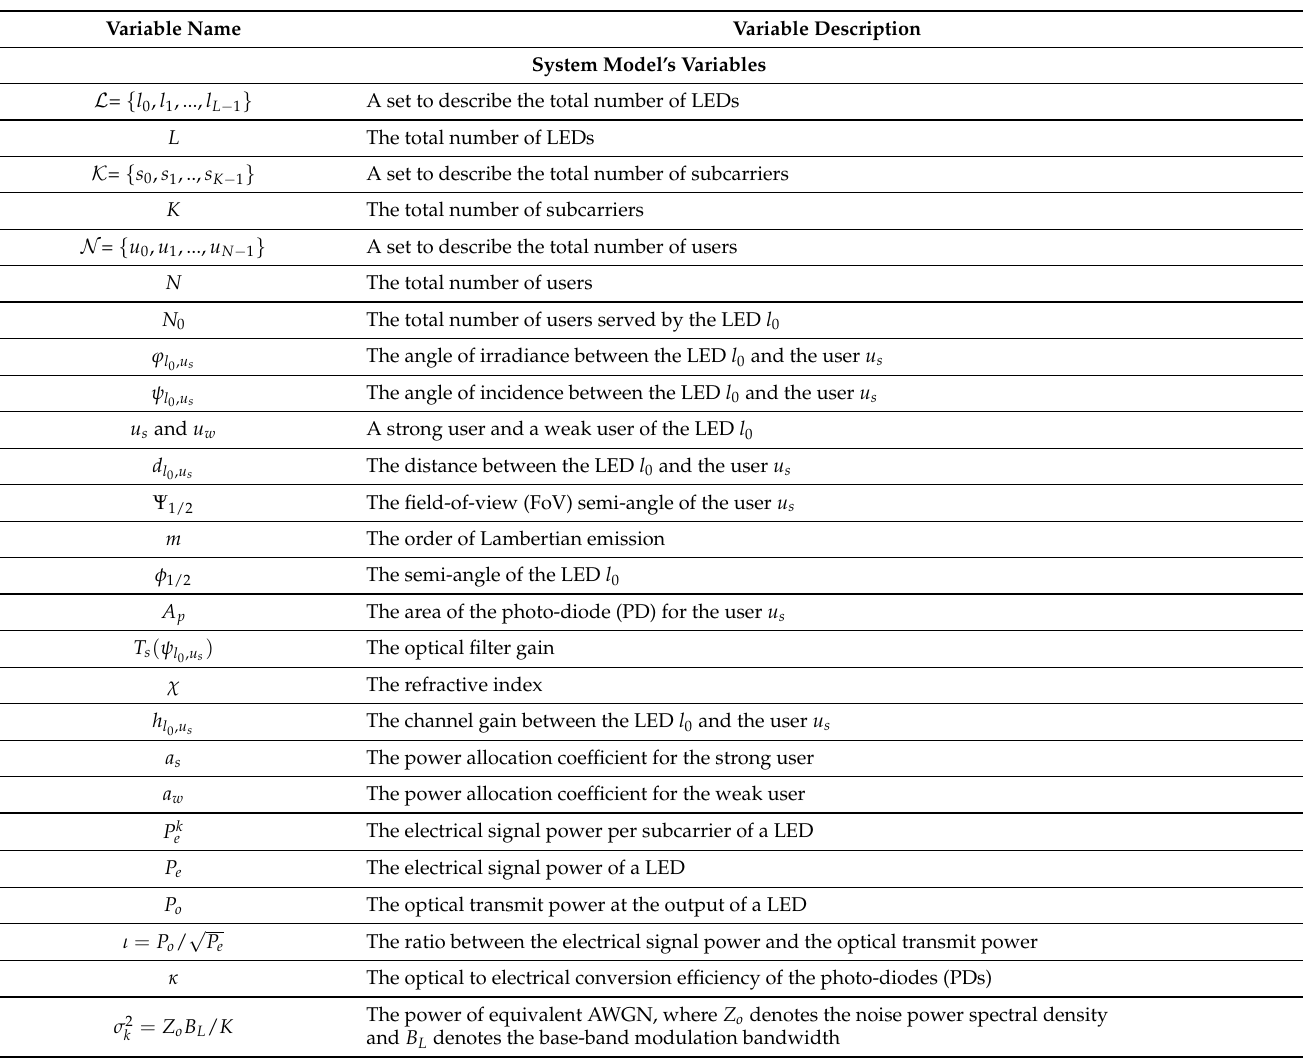
Table 1. List of used